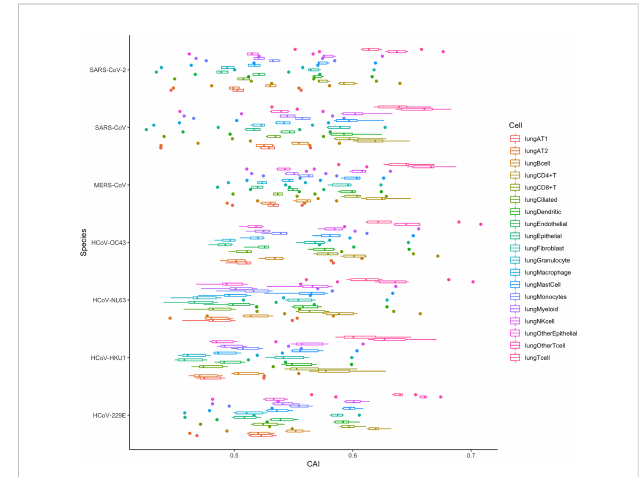
FIGURE 16 The overall CAI value distribution of all ORFs for the reference genomes of seven different coronaviruses in each cell type/large group from the lung scRNA-seq dataset shown by box plot. Each box shows the overall CAI value distribution of 6 shared essential genes for a speci fi c coronavirus species in a speci fi c cell type/large group from the